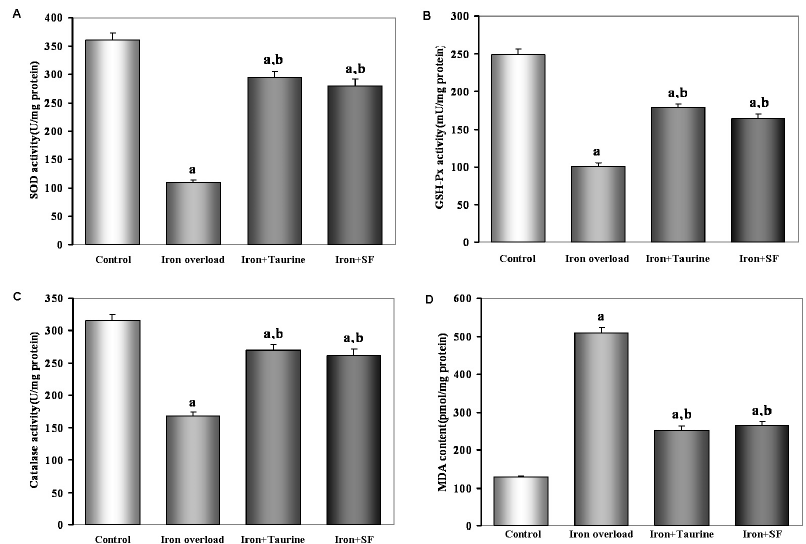
Figure 2. The effect of TAU or SF on the activities of the antioxidant enzymes and lipid peroxidation in iron-overloaded mice. ( A ) SOD; ( B ) GSH-Px; ( C ) catalase; ( D ) MDA. Data represents mean ± SE of 12 independent experiments. a: p < 0.01, vs. control group; b: p < 0.01, vs. iron overload group.